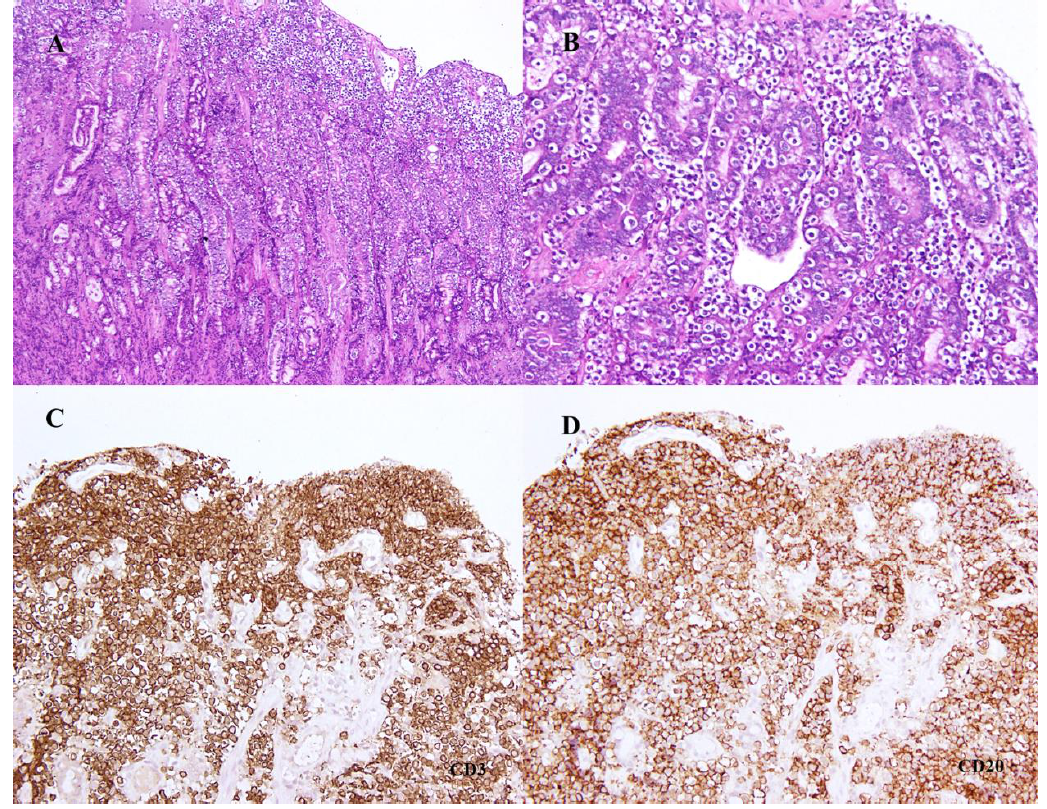
Figure 2. ( A , B ) Microphotographs of endoscopic biopsies of duodenal mucosa showing severe infiltration of the epithelium of the villi by small lymphoid cells identical to the ones in the gastric mucosa (H&E, ( A ) ×40 and ( B ) ×100). ( C , D ) Immunohistochemistry for lymphoid T-cells ( C ) (anti-CD3) and B-cells ( D ) (anti-CD20) (Mayer ’ s hematoxylin, ×40).